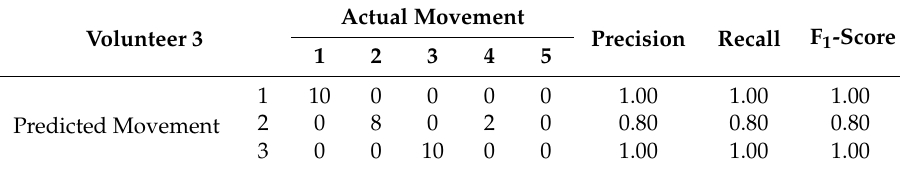
Table A3. Results Volunteer 3.